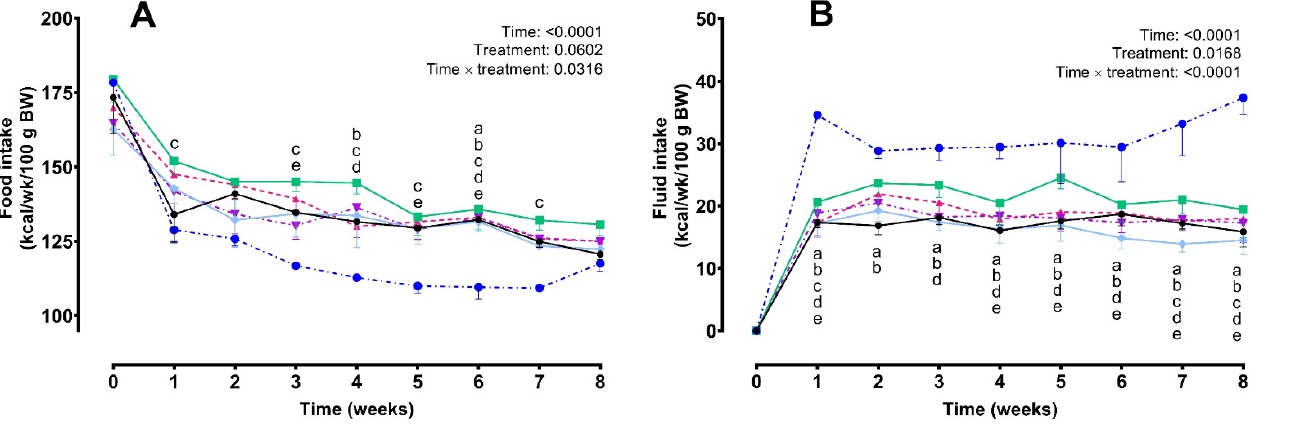
Figure 3. Effects of NNS on food intake ( A ), fluid intake ( B ) and total energy intake ( C ) in the ND-treated group throughout 8 weeks of treatment (phase 2). Data are expressed as mean ± SEM. ( n = 6–8 animals per group). Two-way RM ANOVA followed by Tukey’s post hoc test was used. Different lowercase letters in each time point indicate significant differences between the sucrose group (SUC) and other groups: (a) GLU, glucose; (b) SCL, sucralose; (c) ASP, aspartame; (d) STV, stevia; (e) REB, reb A ( p < 0.05). In the HFD-fed rats, no differences were observed between NNS and GLU (control), moreover, in contrast with the ND results, no reduction of the weekly food intake was observed after SUC consumption. Data analysis showed no significant differences among treatments ( F = 0.3806, p = 0.8897) or in the interaction time × treatment ( F = 0.6175, p = 0.9665) (Figure 4A). Regarding fluid intake, data analysis showed differences between